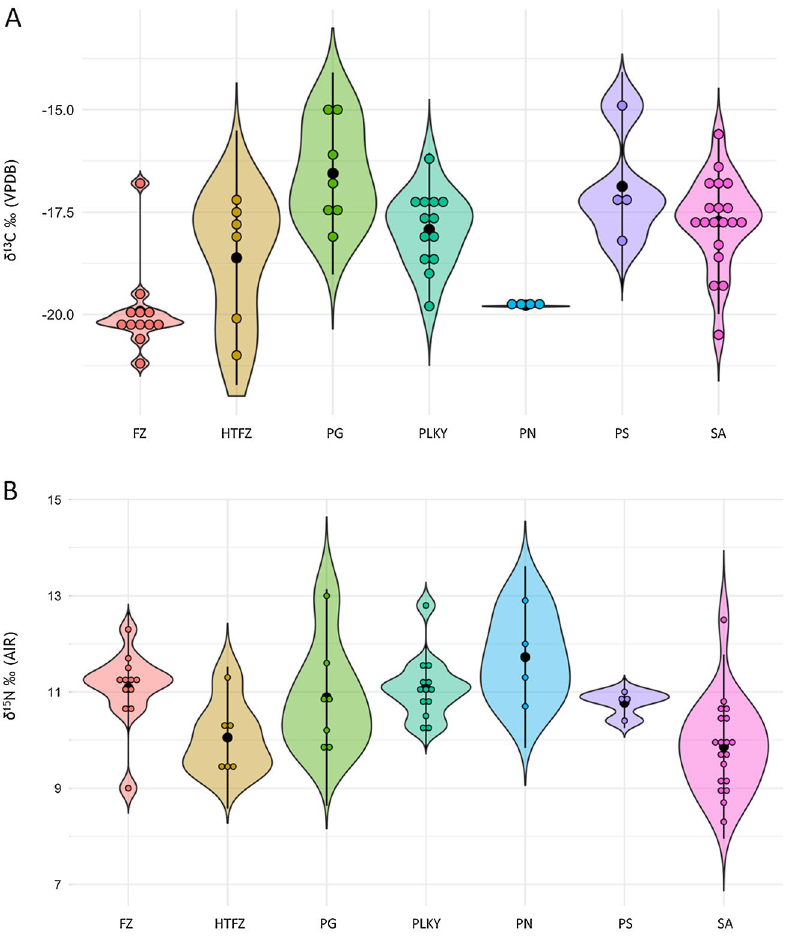
Figure 5. Violin plot of human δ 13 C and δ 15 N ratios by cultures listed in roughly chronological order: PN (Proto-Nagyrév, n = 4), FZ (Füzesabony, n = 12), HFTZ (Hatvan or Füzesabony, n = 6), PLKY (Piliny or Piliny/ Kyjatice, n = 14), PG (pre-Gáva or Gáva, n = 8), PS (Pre-Scythian/Mezőcsát, n = 4), and SA (Scythian/Vekerzug, n = 19). Center black dot represents mean; center black line represents